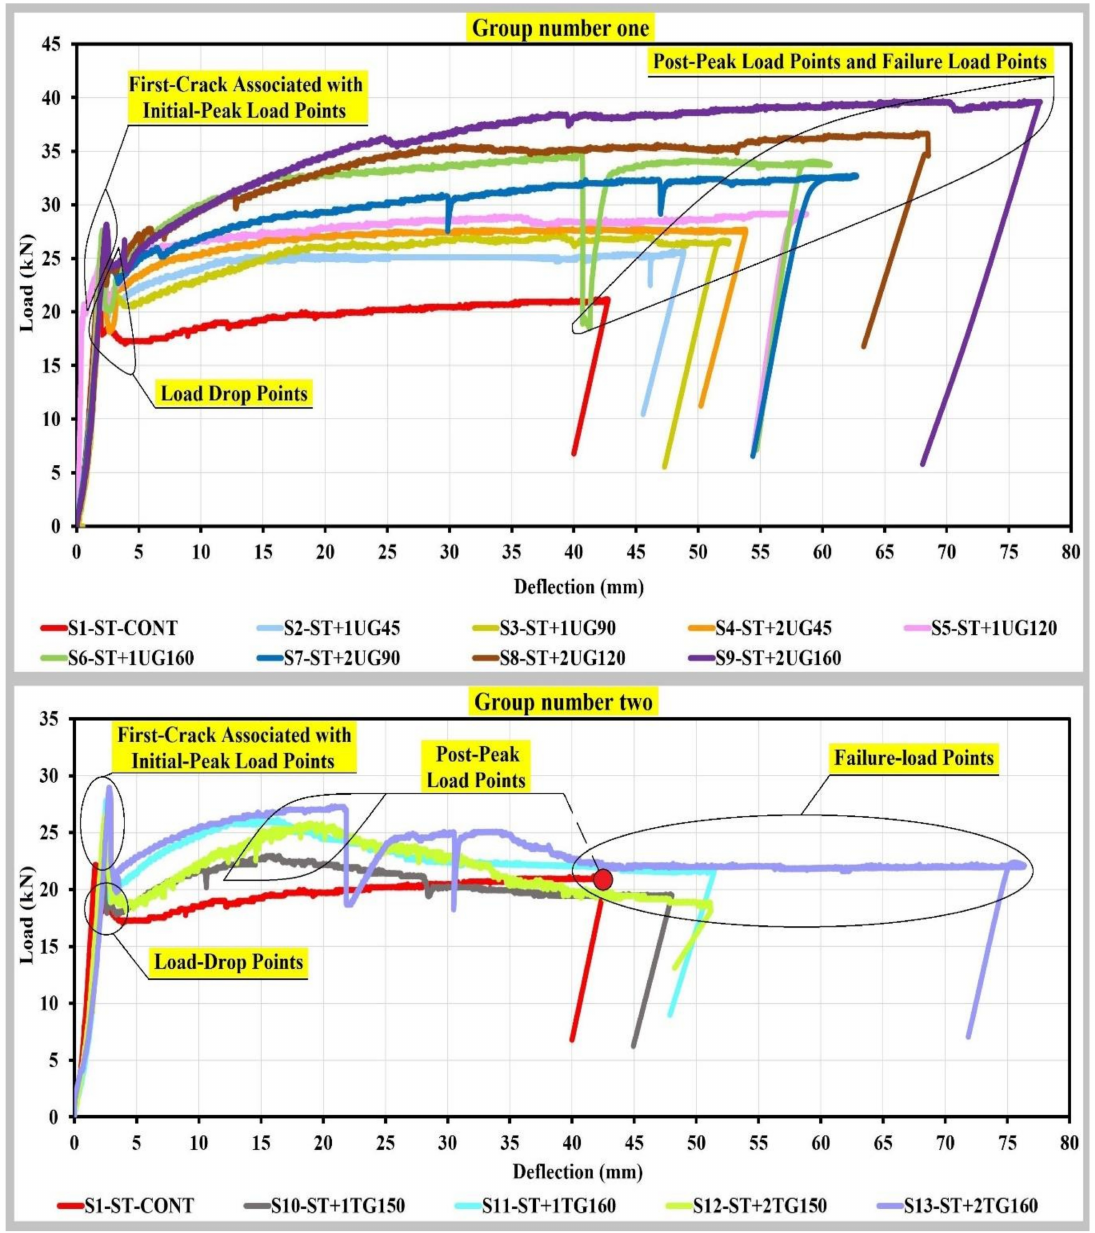
Figure 7. The load-deflection curves per each group concrete slabs in comparison to the concrete control